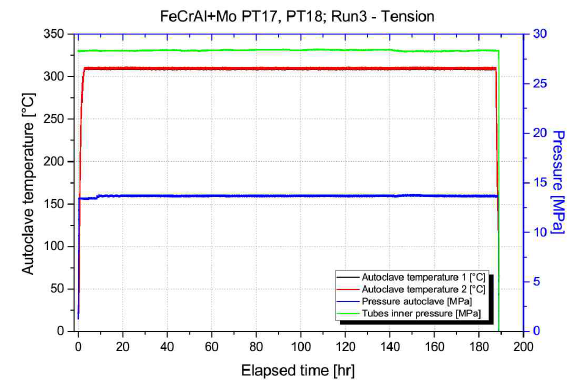
Figure 15. FeCrAl+Mo Run 3 - autoclave tempera- ture and pressure, inner tube pressure.